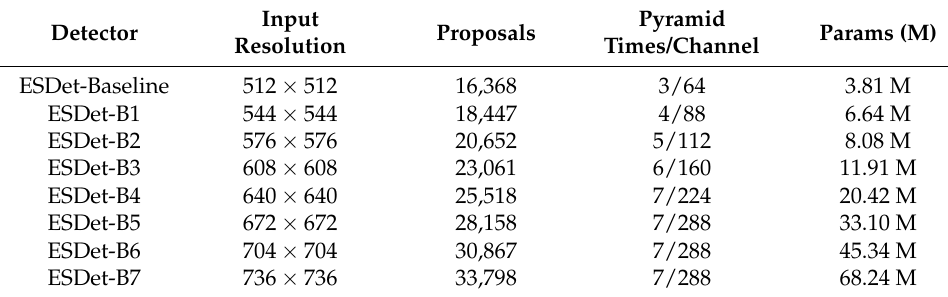
Table 3. Expand the network based on the